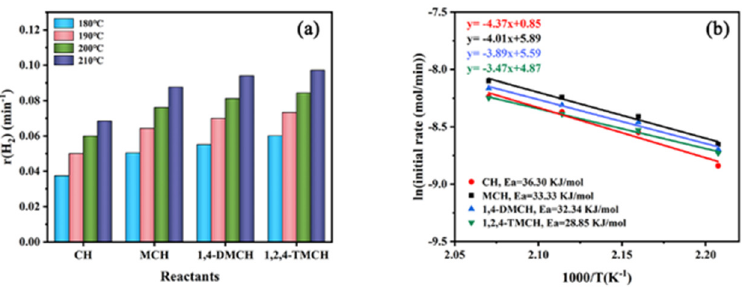
Figure 9. ( a ) r vales at 180 – 210 °C; ( b ) Arrhenius plots for CH, MCH, 1,4-TMCH and 1,2,4-TMCH dehydrogenation with Pt/CN catalyst.